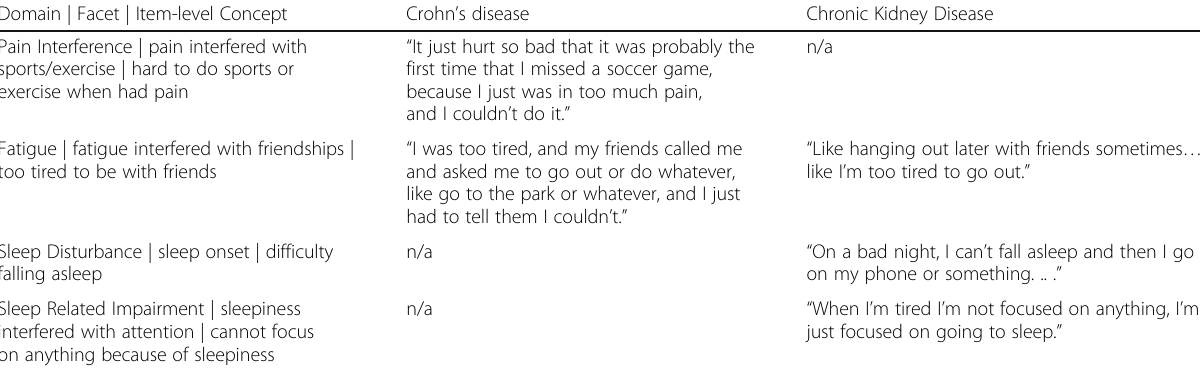
Table 2 Quotations from interviews and their categorization by Domain, Facet, and Item-Level Concept Domain | Facet | Item-level Concept Crohn ’ s disease Chronic Kidney